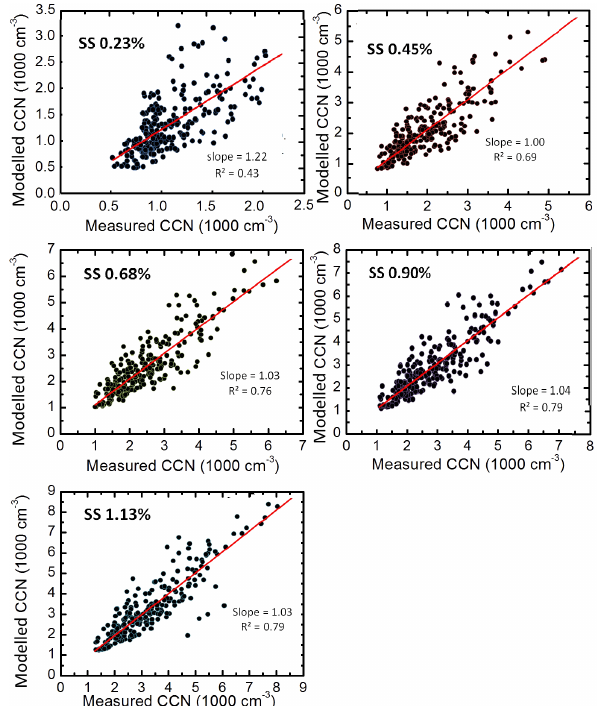
Figure 7. Comparison of modeled and measured CCN concentra- tions using internal mixing for the 5 estimated supersaturation using the inorganic size dependence based on MOUDI+PIXE